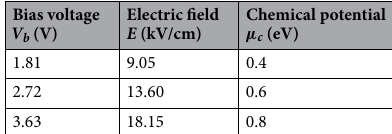
Bias voltage V b